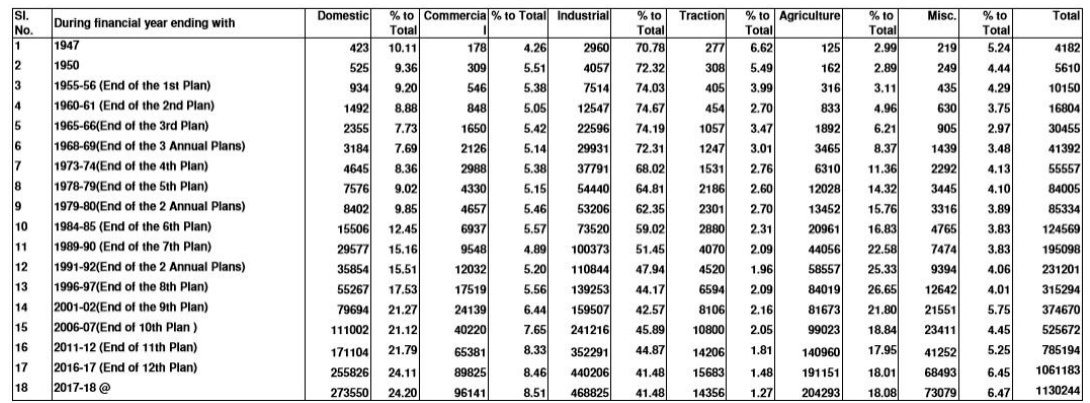
Figure 1. Category wise TEC growth in India (1947–2018).